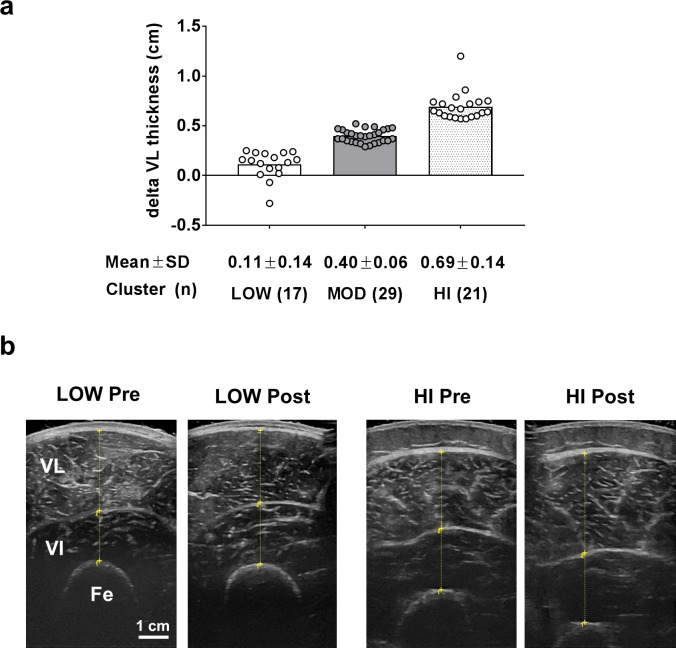
VL thickness as a clustering variable.Legend: K-means cluster analysis was used to differentiate LOW, MOD and HI responders (panel a). Data are presented as individual respondent values, bar graph values indicate group mean values, and mean ± standard deviation values are presented below each bar. Panel b depicts PRE versus POST representative ultrasound images (scale bar = 1 cm); abbreviations: VL, vastus lateralis; VI, vastus intermedius, Fe, femur.